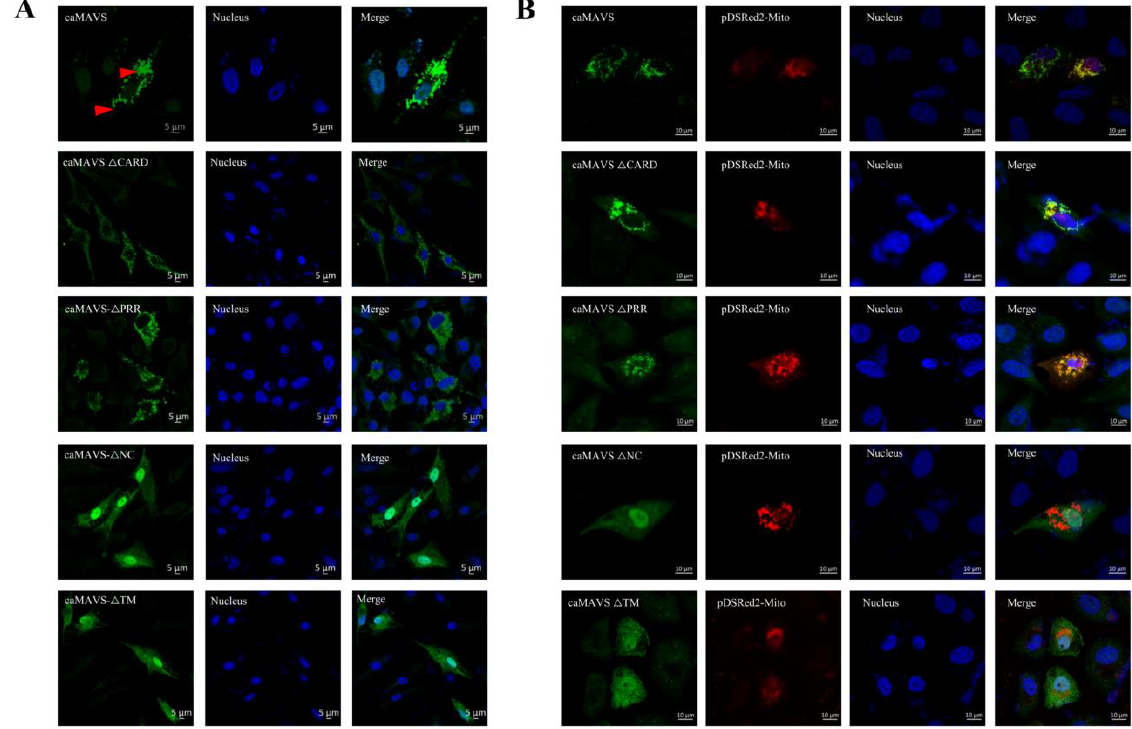
Figure 3. Localization study of caMAVS and its mutants. ( A ) Expression plasmids encoding caMAVS and its different deletion mutants were transfected into Vero-SLAM cells. At 36 h post transfection, cells were fixed and stained with Myc primary antibodies and secondary Alexa-488 labeled antibodies. ( B ) To verify the colocalization of caMAVS (green) and Mitochondria (red), expression plasmids encoding Myc tagged caMAVS and its mutants were transfected together with pDsRed2-Mit. At 36 hpt, cells were fixed and stained as in panel A.